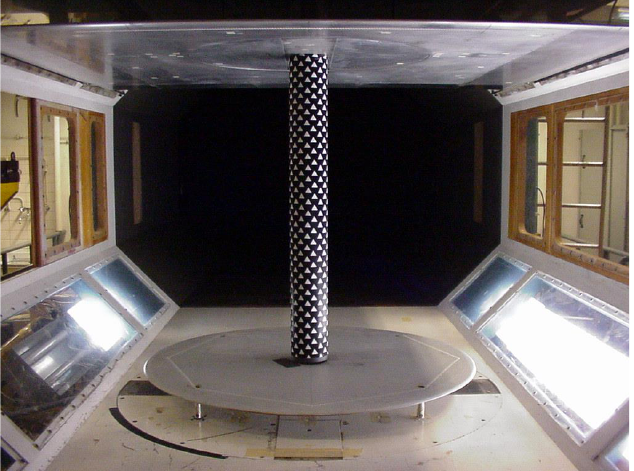
Figure 3. Setup of a 90 cm span circular cylinder in the Delft University low-speed, low-turbulence wind tunnel. In this case, the aerodynamic characteristics of a fabric with small rubber triangles were determined. The diameter of the cylinder is 11 cm.